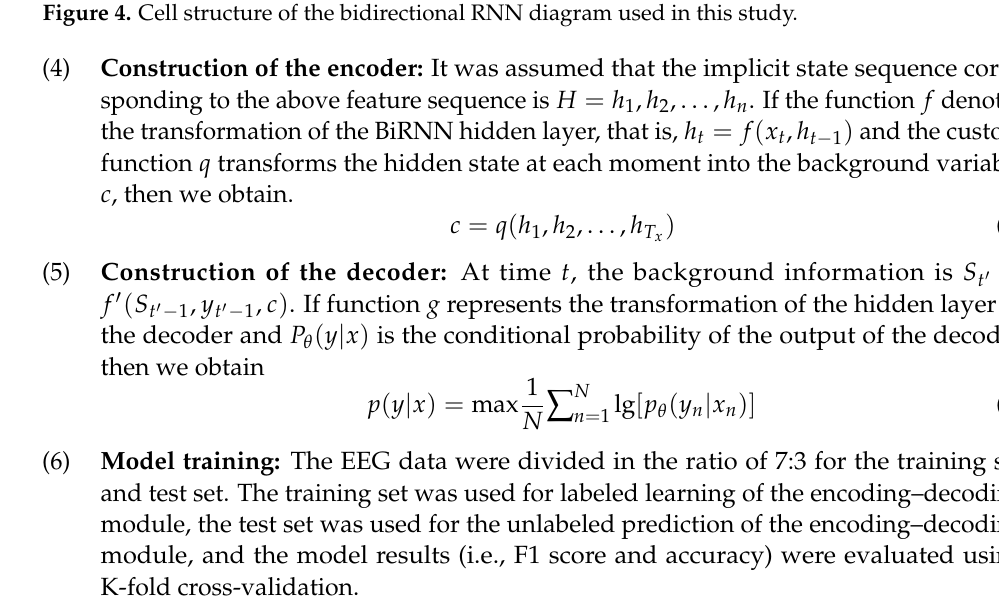
Figure 4. Cell structure of the bidirectional RNN diagram used in this study.